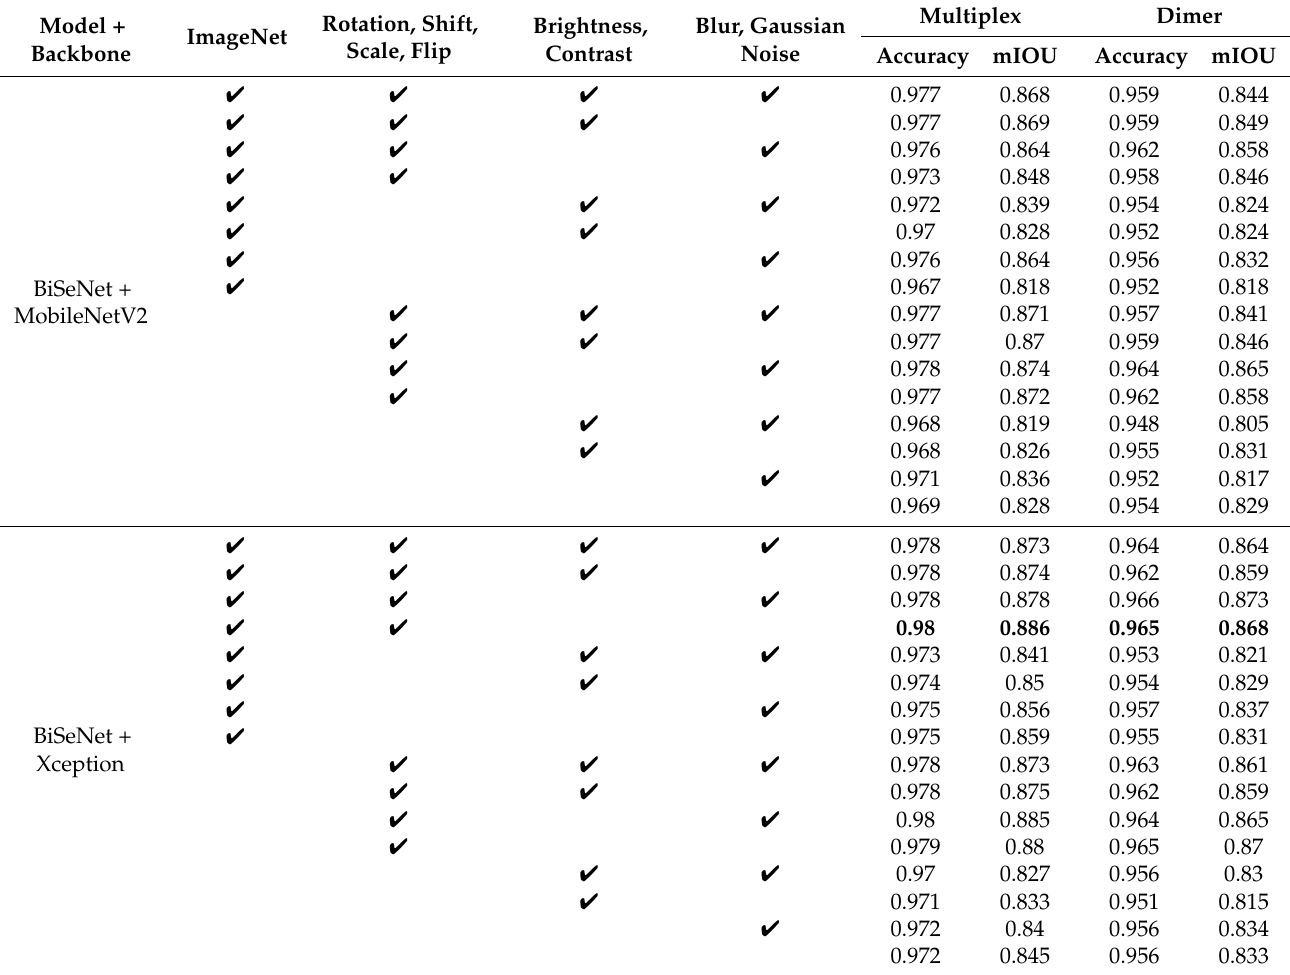
Table 2. Summary of fluorescence target segmentation results for BiSeNet model (mIOU: mean IOU over two